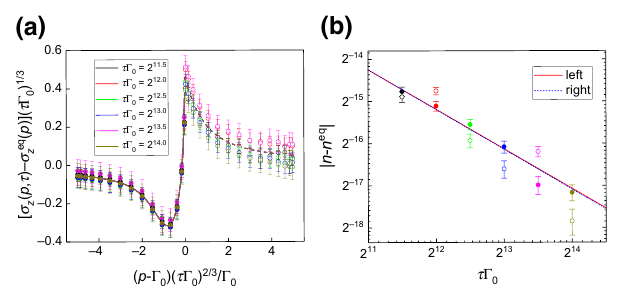
FIG. 3. The Kibble-Zurek scaling of defect production for parameter ramps across non-Hermitian EPs. (a) The data col- lapse for the momentum-resolved defect density for the full non-Hermitian drive. (b) The total defect density relative to the adiabatic values as a function of the ramp time τ . As discussed in the main text, we sample the left ( p < (cid:5) 0 ) and right ( p > (cid:5) 0 ) regions separately. The red solid (black dashed) line in (b) shows the results for the best power-law fits | n − n eq | ∼ τ − α for the left (right) region, with the fitted exponents α = 0.94 ( 7 ) in both